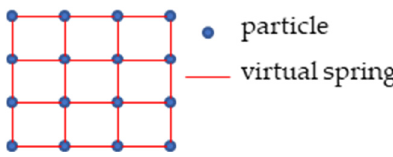
Figure 6. Cloth grid initialization.